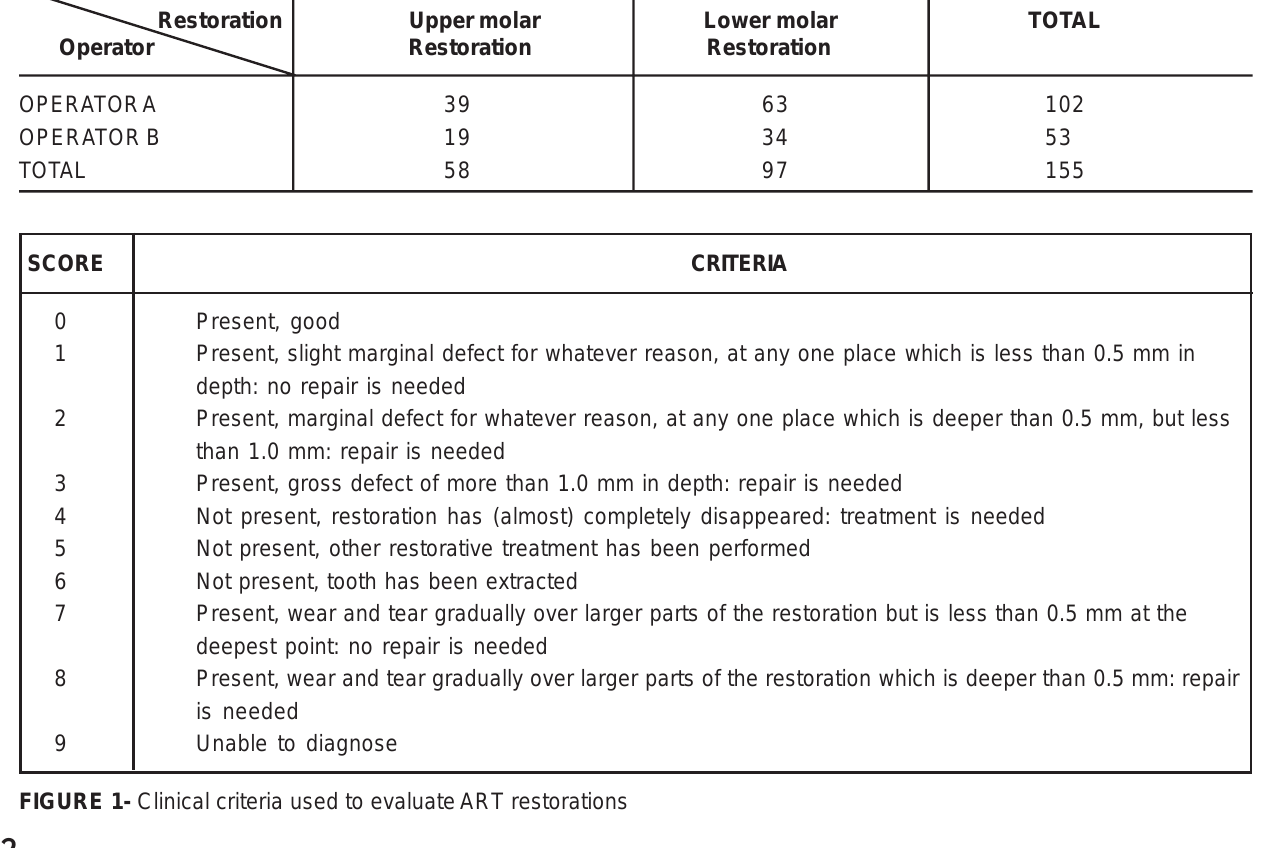
TABLE 1- Sample distribution of the ART restorations according to operator and to its position in upper or lower arch